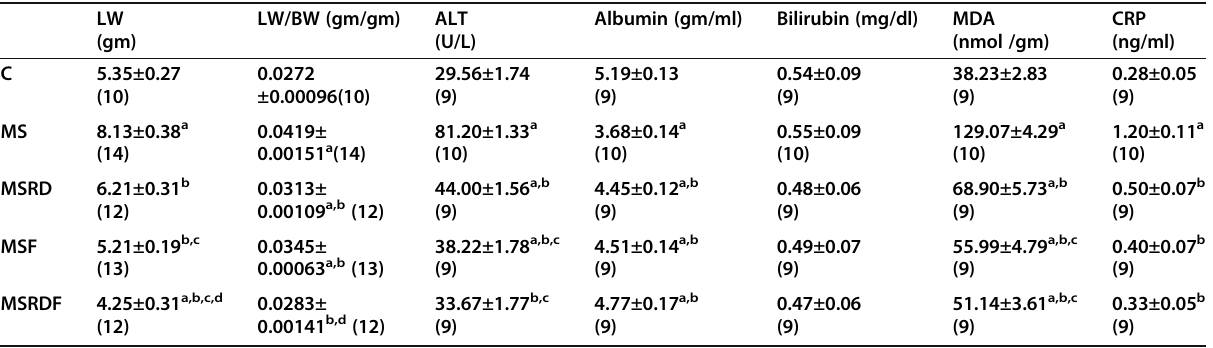
Table 5 The final liver parameters and serum C-reactive protein (CRP) in the five study